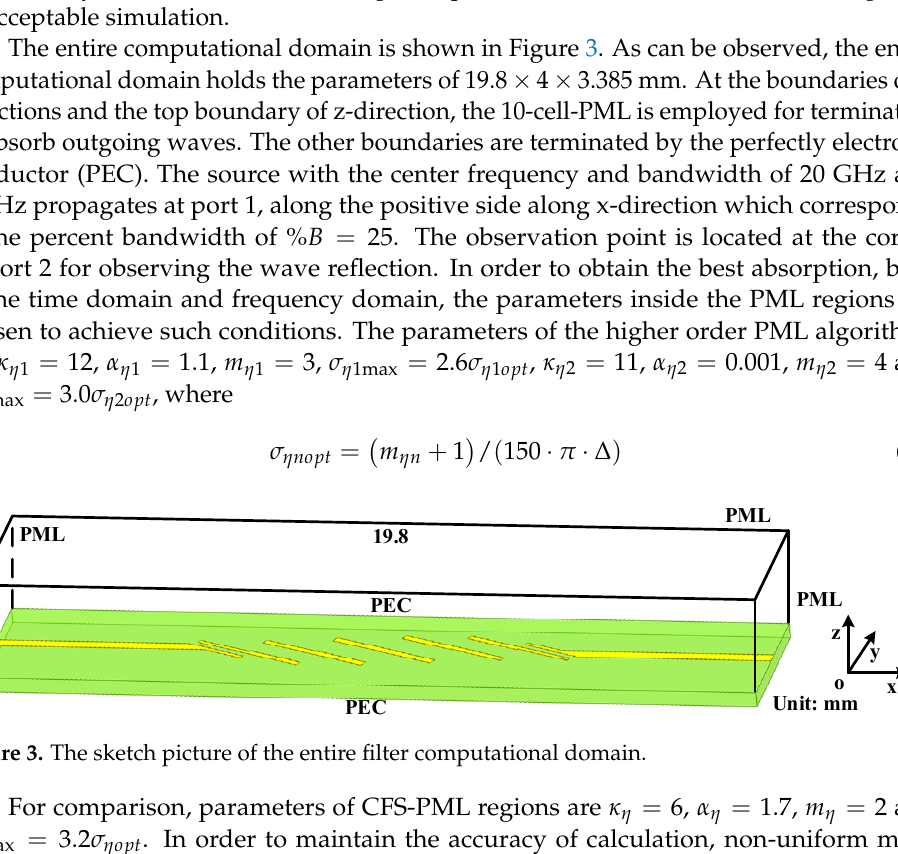
. In order to maintain the accuracy of calculation, non-uniform mesh sizes